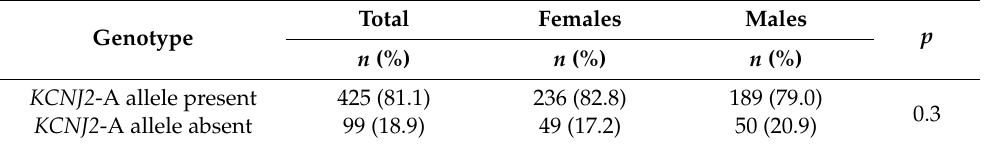
Table 3. KCNJ2 -rs236514 variant (A) allele distributions by total cohort and by sex.